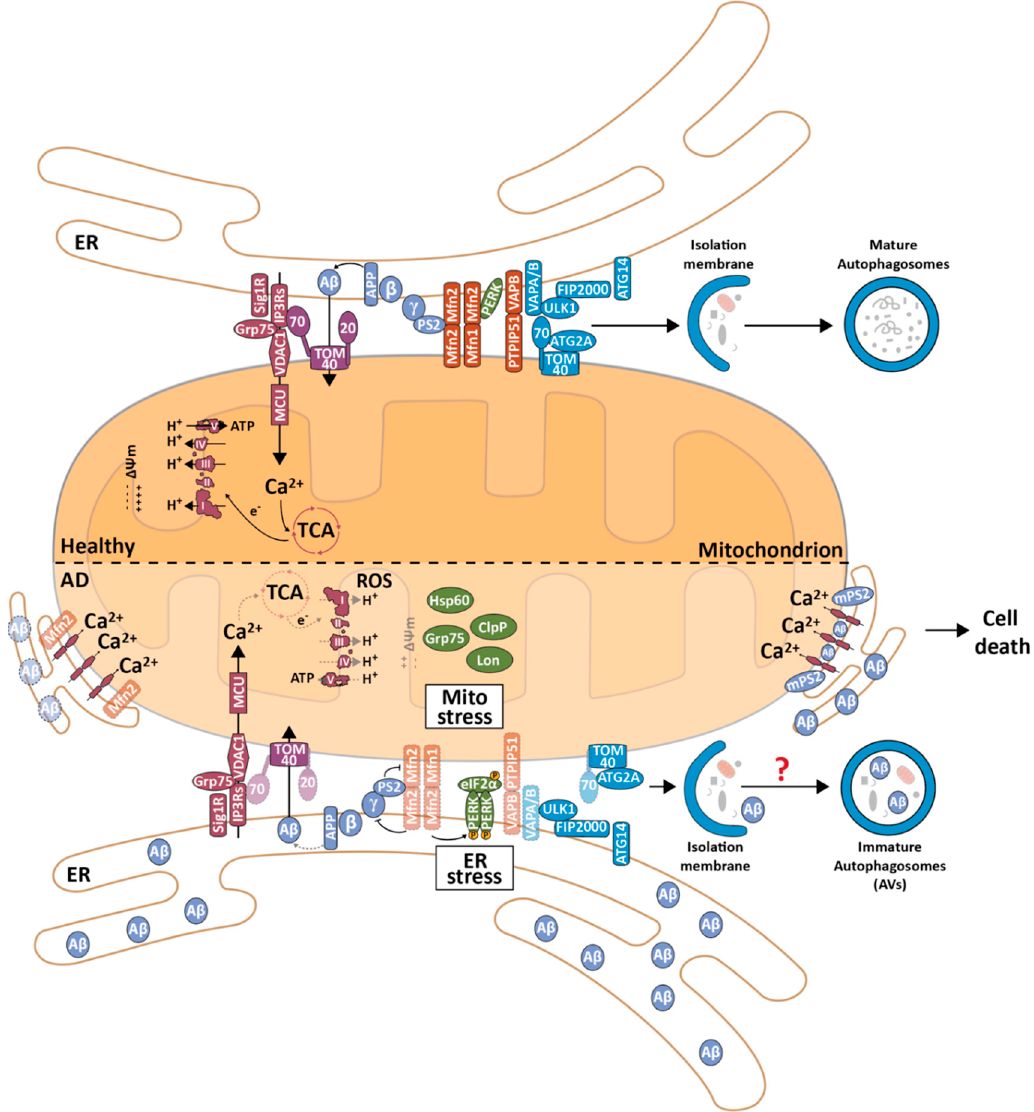
Figure 1. MERCS in health and in AD. In healthy controls (upper part of the figure), different functions of MERCS are integrated to maintain cell homeostasis. The IP3Rs-Grp75-VDAC1 complex together with the MCU complex allows the entry of Ca 2+ into mitochondria, where it can boost the TCA cycle, inducing ATP production. This complex, together with Mfns and the PTPIP51 and VAPB pair, can modulate the connectivity between the ER and mitochondria. Additionally, the formation of the isolation membrane, which is the precursor to the mature autophagosome, originates at MERCS and can be modulated by the function or ultrastructure of MERCS. Similarly, A β also originates in this subcellular region. In AD, the connectivity between the ER and mitochondria is enhanced and Ca 2+ inside mitochondria is upregulated, and mitochondrial dysfunction, activation of the UPR ER and UPR mt , impaired autophagosome maturation and changes in A β levels are increased, which can ultimately lead to cell death. Different colours correspond to proteins involved in different cellular processes and faded colours as well as dashed lines represent the downregulation of the process or protein level/function. mPS2 represents PS2 with a FAD mutation.